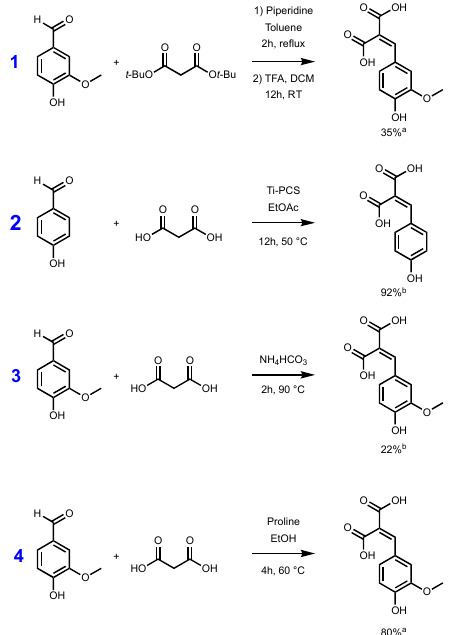
Figure 1. Synthetic pathways to p -hydroxycinnamic diacids according to Vivier et al. [31] (1), Mangala et al . [32] (2), Schijndel et al . [33] (3), and our study (4). [a] Isolated yield; [b] evaluated by HPLC.